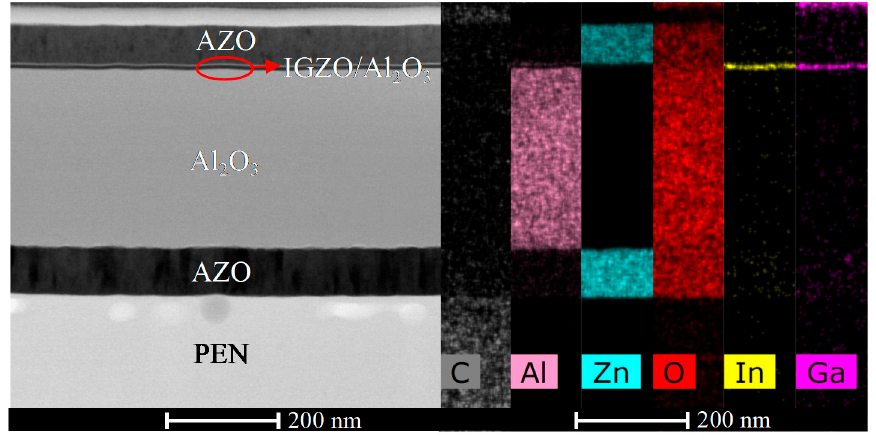
Figure 3. Cross-sectional TEM images and EDS mapping of the TFT.